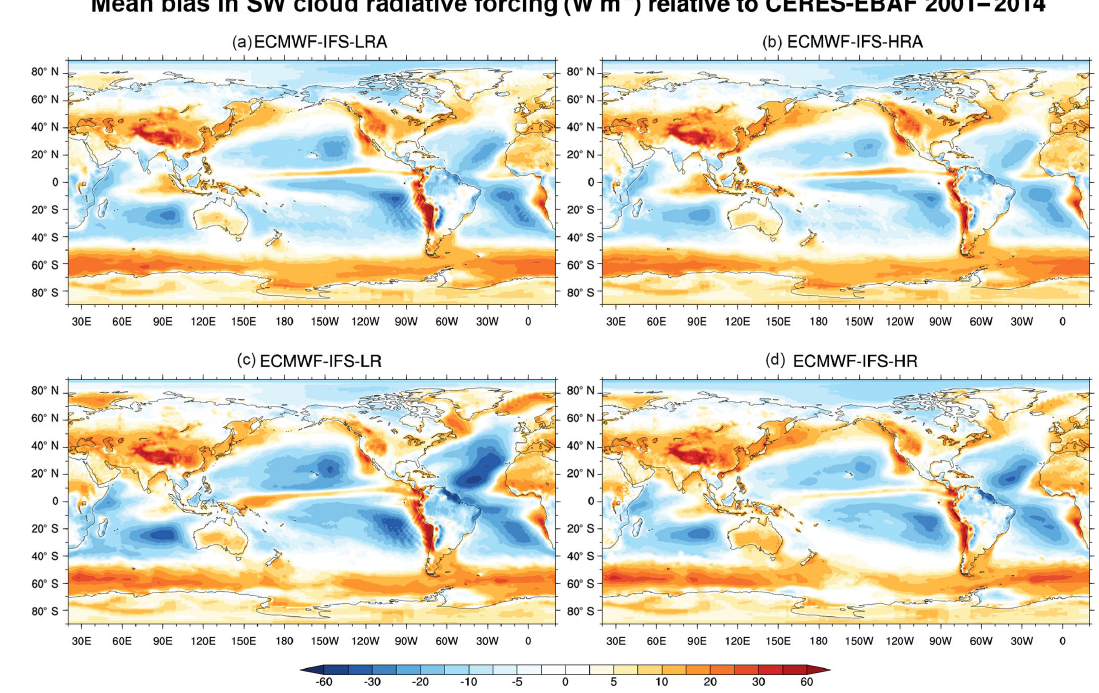
Figure 6. As Fig. 5 but for short-wave radiation